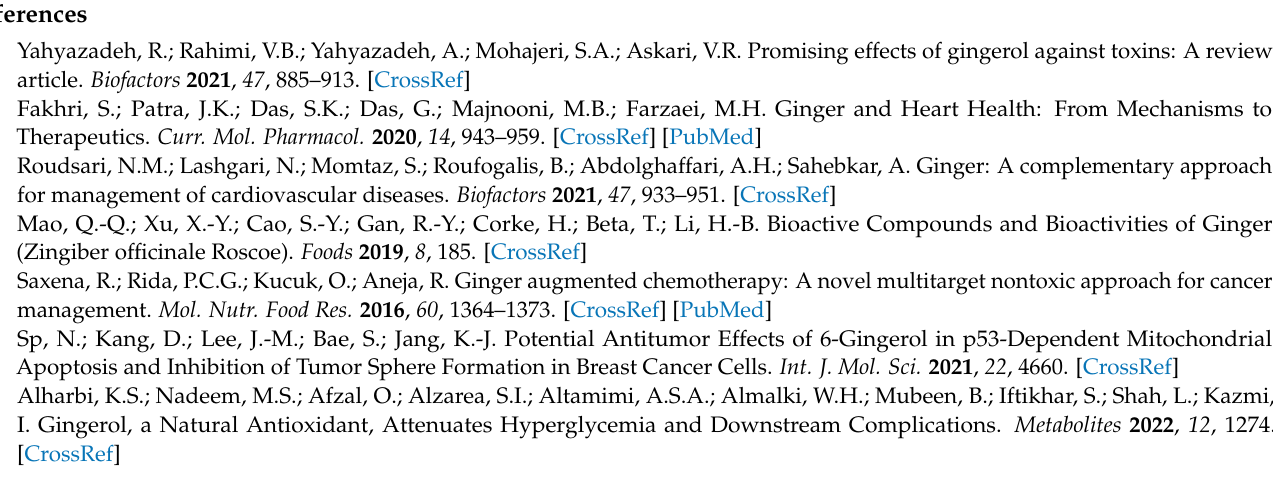
22 , Figure S25: Correlation between the antiplatelet and COX-1 inhibitory activities of the tested compounds; Table S1: Docking results obtained using AutoDockTools 1.5.7 and Discovery Studio visualizer